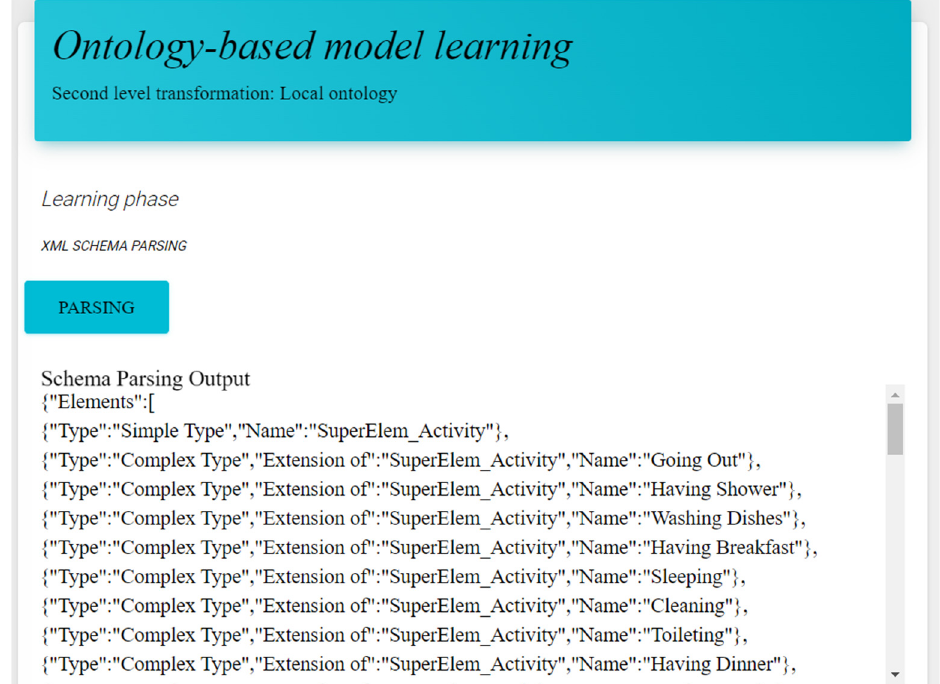
Figure 16. Ontology-based model learning at t 2 in the learning phase, an example of a parsed XML schema.